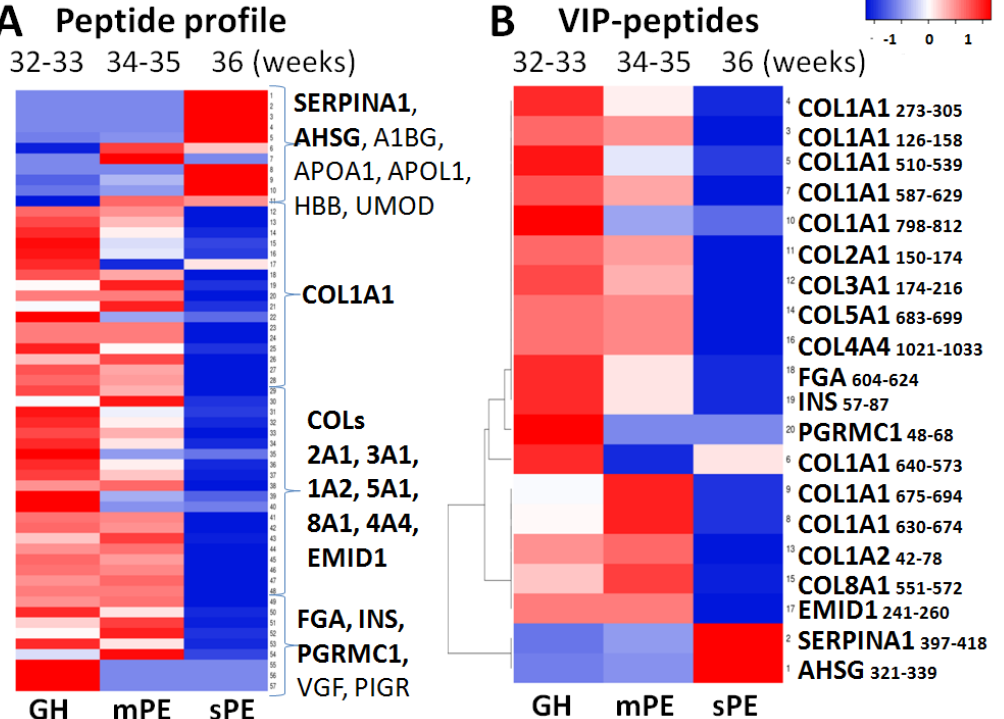
Figure 6. Dynamic urine peptidome changes upon GH progression into PE, on the example of three samples obtained from the same patient at different gestation ages. ( A ) Profiling of the most represented peptide groups (without clustering). ( B ) Hierarchical clustering of VIP-peptide groups found in the compared samples using Kendal’s Tau distance measurement method and average linkage clustering.